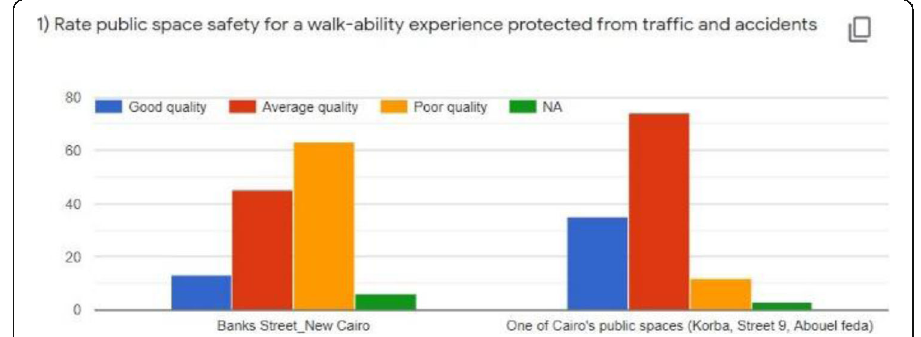
Fig. 16 Protection from traffic in public spaces